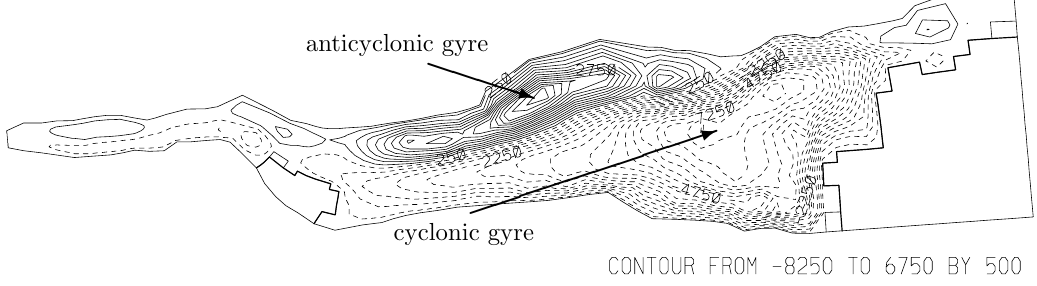
FIG. 11: Stream function of the vertically integrated volume transport in the steady state (6 days after a constant longshore northwest wind sets up). Solid (dashed) streamlines belong to cyclonic and anticyclonic rotations.